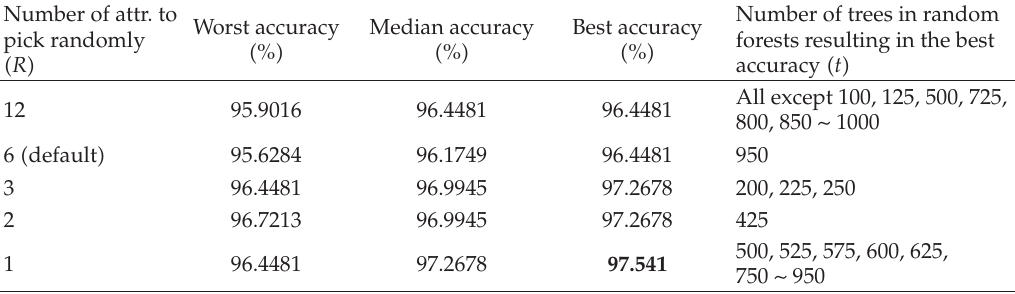
Table 9: The accuracy of random forests for the data set “Dermatology.”